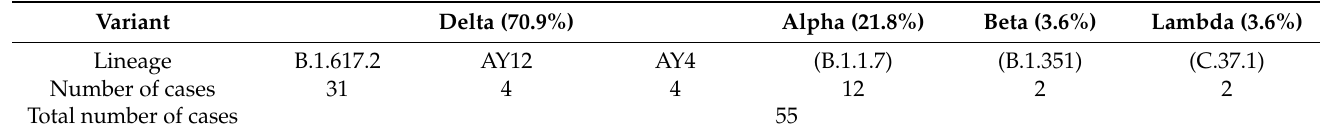
Table 4. Variants identified through sequencing of samples from SARS-CoV-2 positive patients at the hospital during the week the experiment took